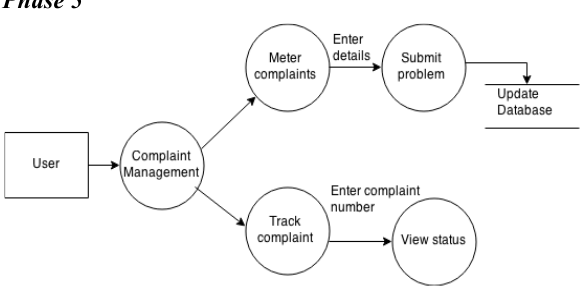
Figure 15. Complaint Management System for the user in ISAU